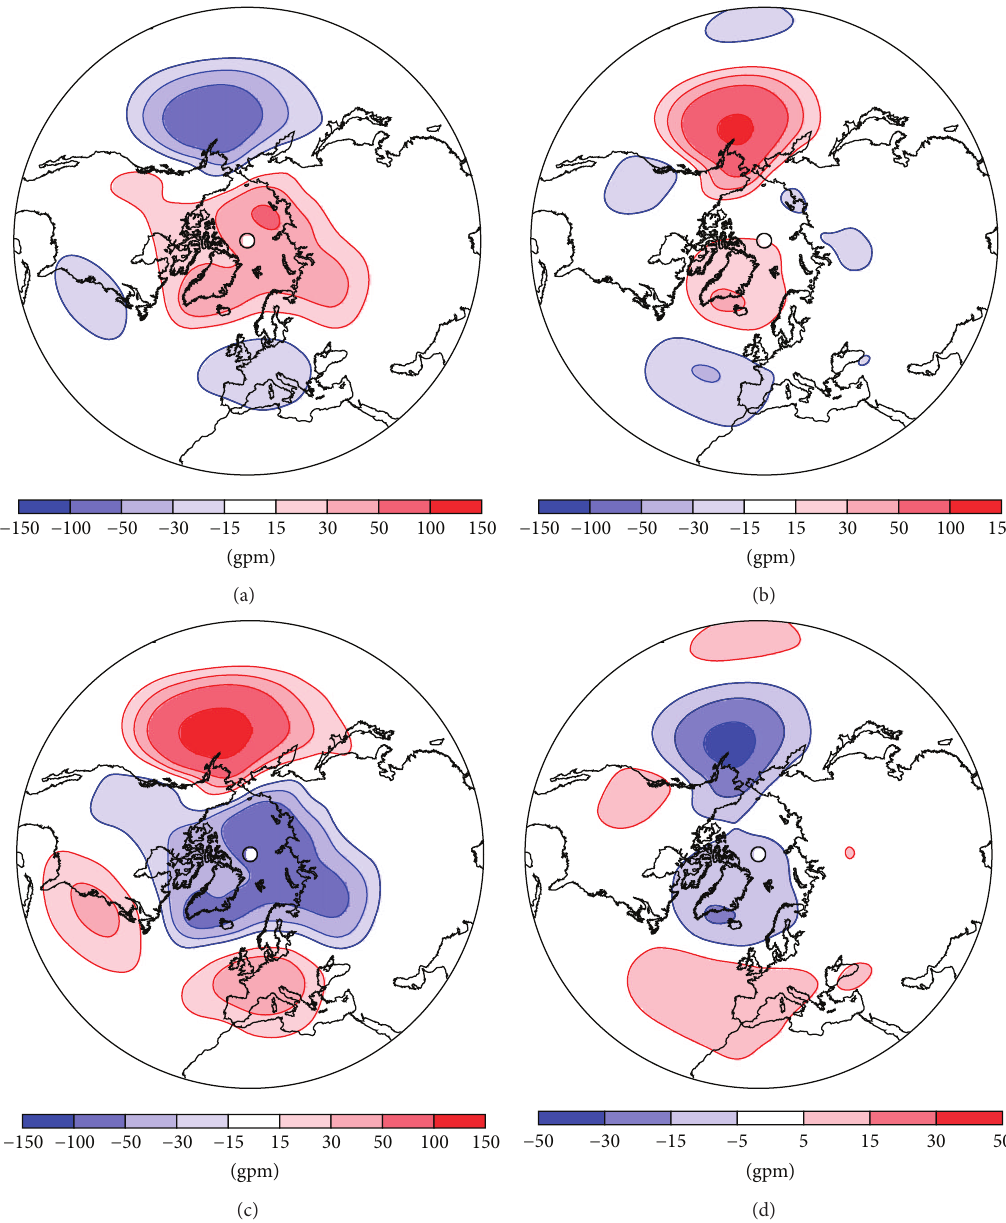
Figure 12: Composite geopotential height (gpm) anomaly patterns of the observed regimes (areas A–D in Figure 10 right) at the 833 hPa level.